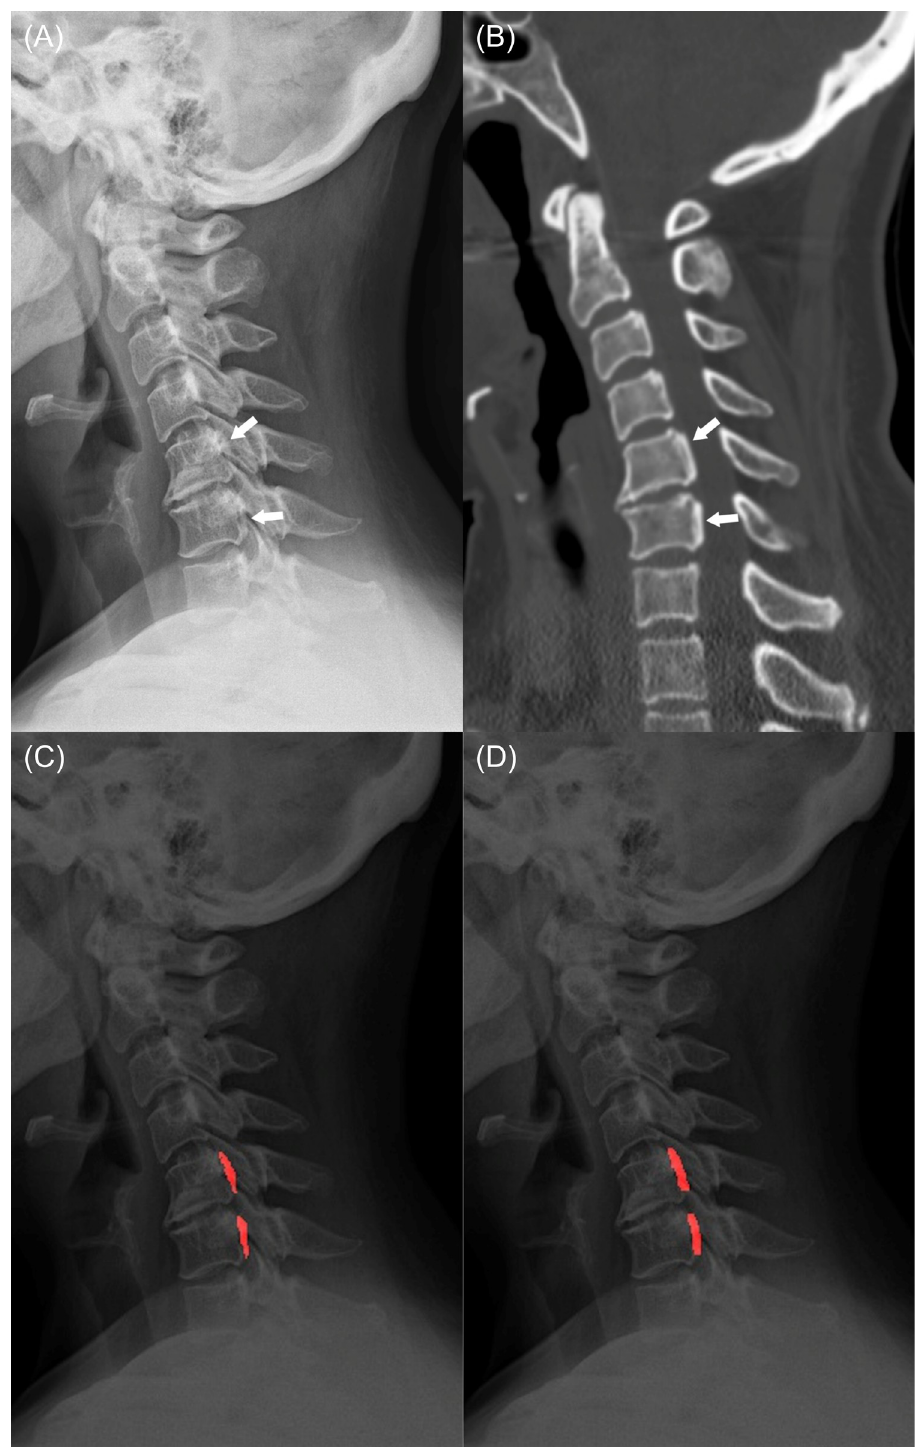
Fig 4. A 51-year-old female patient with segmental-type OPLL. (a) A lateral plain radiograph shows segmental-type OPLL (arrow) at the C5-6 level. (b) A sagittal image of cervical spine CT also demonstrates the segmental ossifications (arrow) at C5-6 level (window width = 2000 HU, window level = 500 HU). (c) OPLL lesions annotated by a radiologist on the plain radiograph. (d) The deep-learning model correctly predicted the segmental-type OPLL, which was overlooked by two observers. OPLL, ossification of the posterior longitudinal